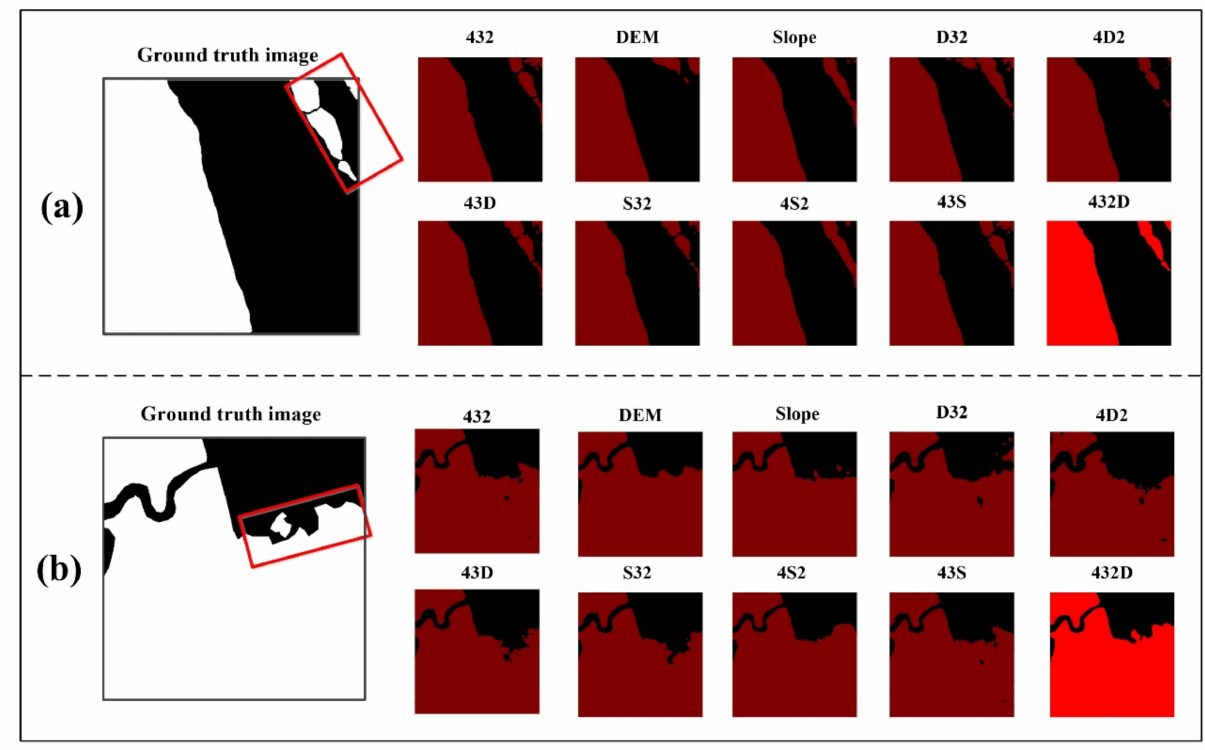
Figure 7. Demonstration of segmentation results of ( a ) A case presenting discrete distribution of cone karst landscape using ten different training datasets and ( b ) A case presenting variable boundary of cone karst using ten different training